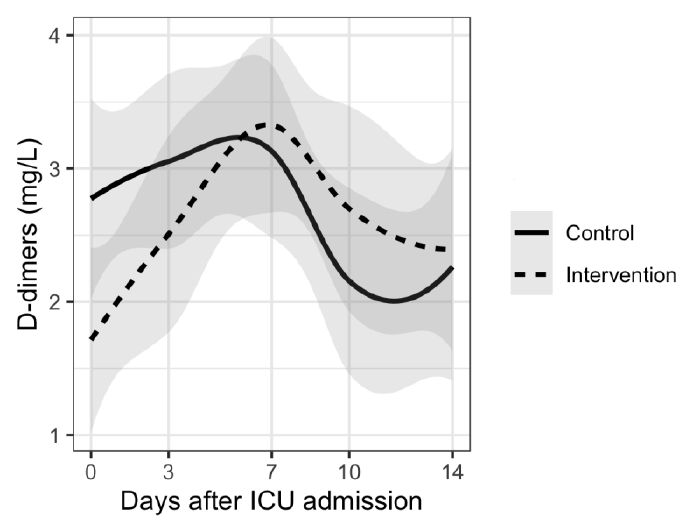
Figure 3. Mean D-dimer levels and trends during 14 days from ICU admission.